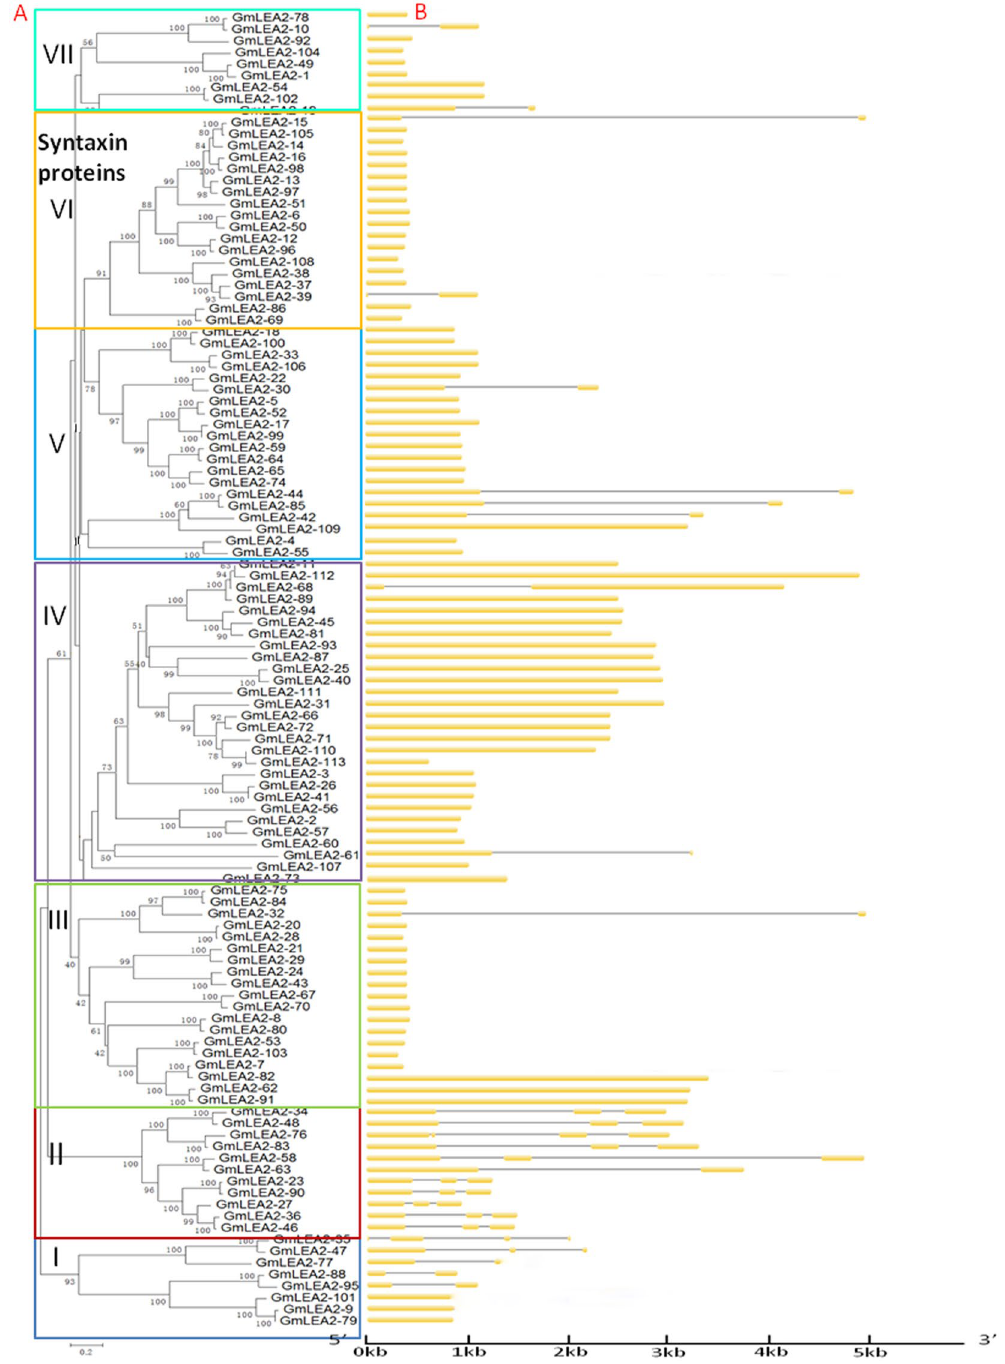
Figure 1. Phylogenetic analysis and gene structure of soybean genes harboring LEA2 domain. ( A ) Phylogenetic tree or ( B ) Exon/intron structures of soybean LEA2 proteins Yellow boxes represent exons, and black lines indicate